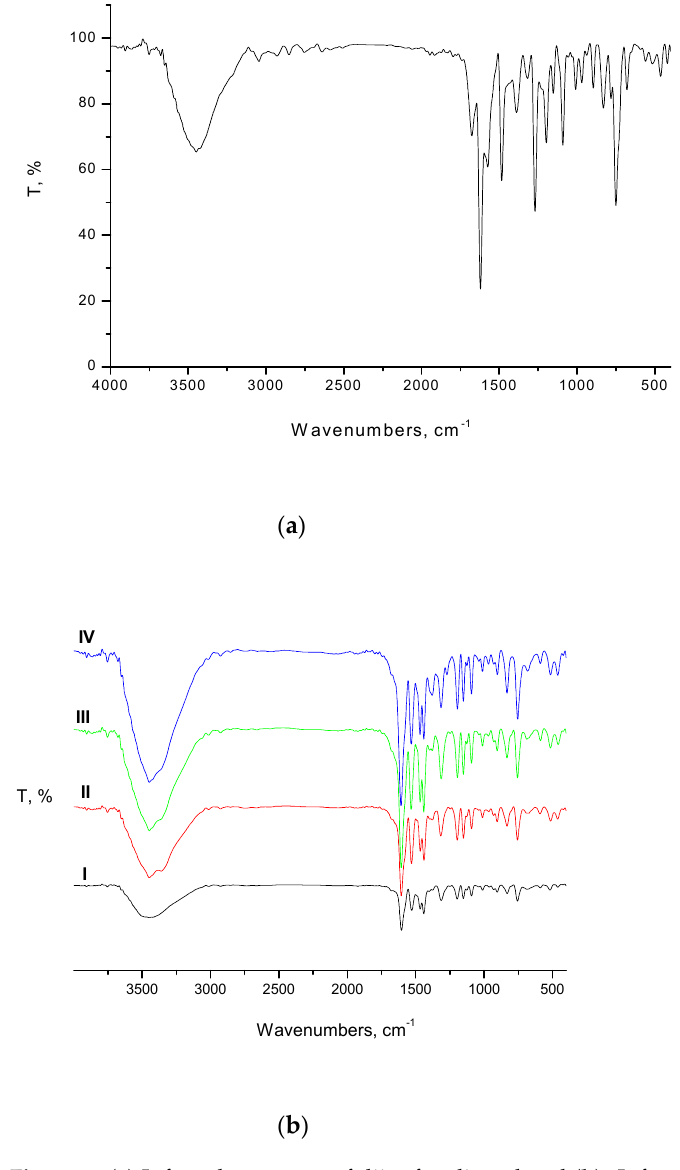
Figure 5. ( a ) Infrared spectrum of diim free ligand and ( b ). Infrared spectra of I: Co(II), II: Ni(II), III: Cu(II) and IV: Zn(II) diim complexes. Table 2. Data for infrared spectral bands (cm –1 ) for diim ligand and its metal complexes.